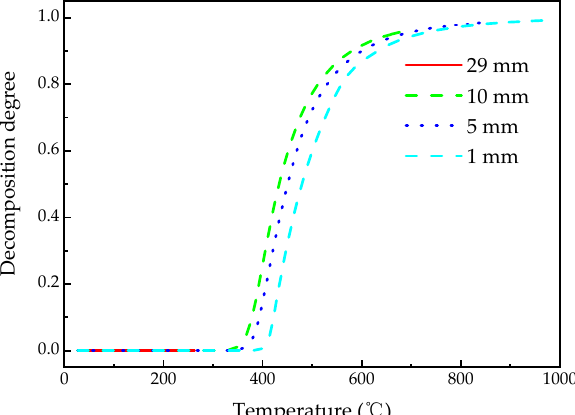
Figure 9. The change of decomposition degree with temperature for different positions of the glass fiber/phenolic resin composites.